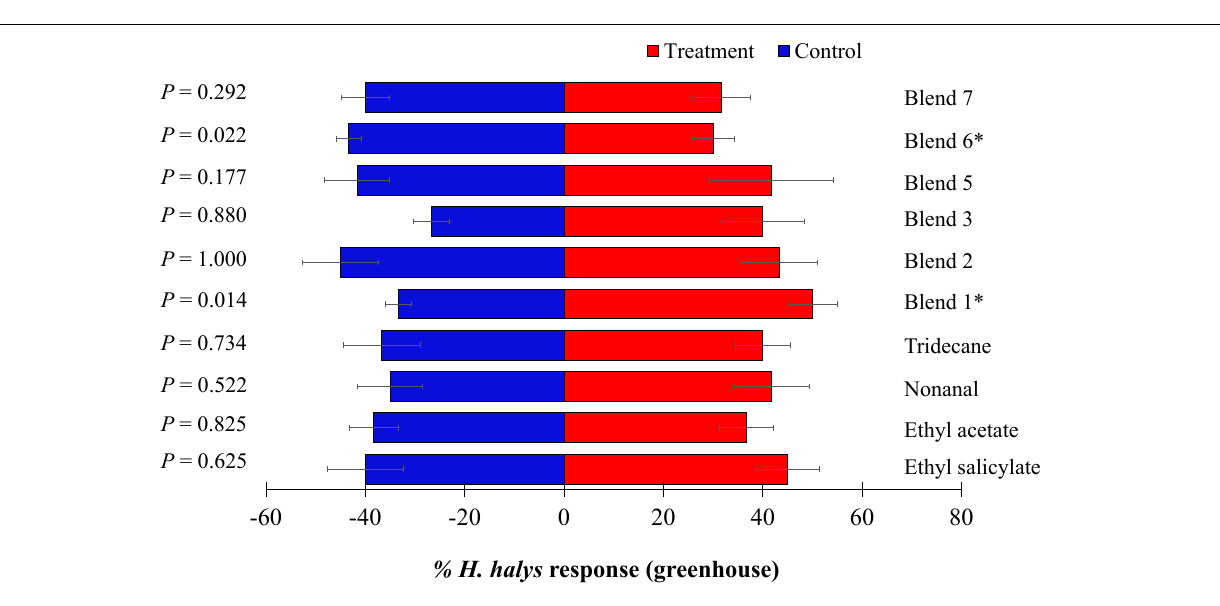
FIGURE 4 | Responses of Halyomorpha halys nymphs to synthetic compounds in greenhouse. Blend 5 [ES and ( ± )-AP], blend 6 phenol, UN, decane, BC, and NO at 2 × ), and blend 7 (phenol, UN, decane, BC, and NO at 5 × ). Asterisks indicate significant difference between the treatments at p = 0.05 using likelihood ratio